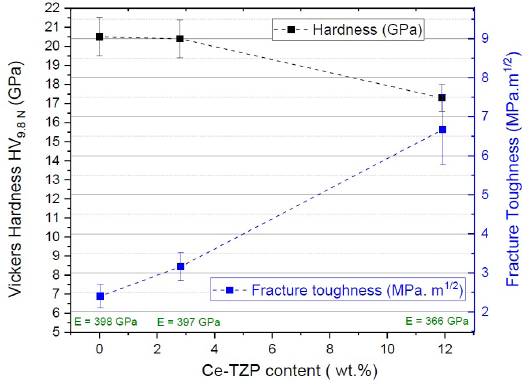
Figure 6. Hardness, fracture toughness, and modulus of elasticity (E) of the sintered Al O -samples as a function of Ce-TZP 2 3